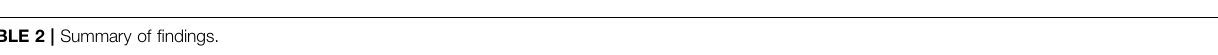
TABLE 2 | Summary of fi